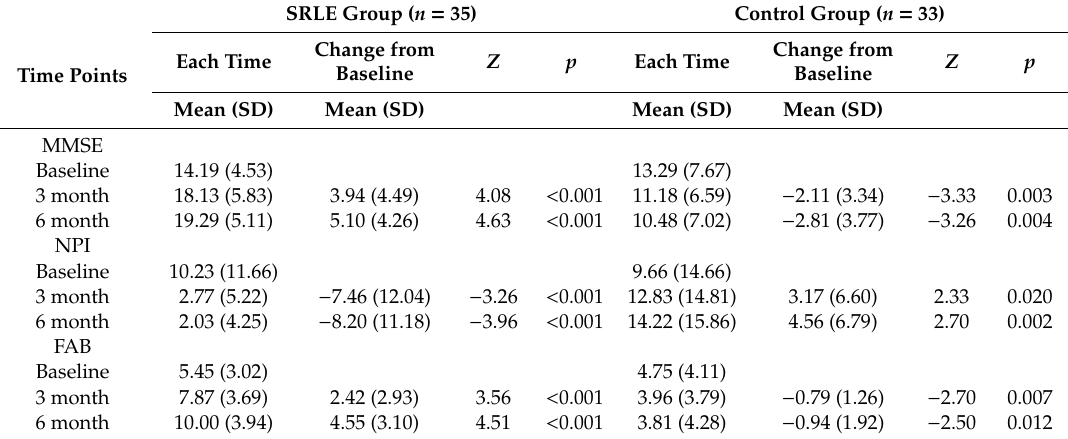
Table 2. Scores of MMSE, NPI and FAB by group and time ( n = 68). SRLE Group ( n = 35) Control Group ( n =